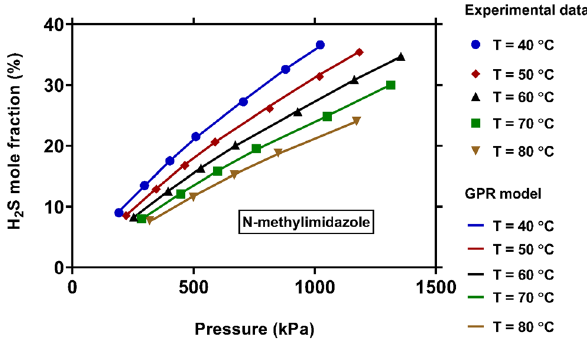
Figure 8. Comparison between experimental values of H 2 S solubility and those predicted by the novel model at various pressures and temperatures (created by GraphPad 8.4.3.686 145